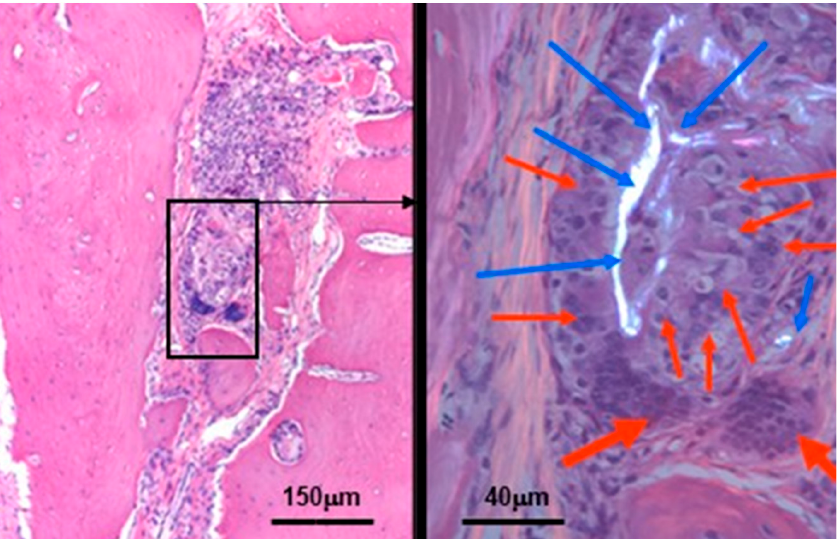
Figure 14. Residual silica compounds following mesoporous BTCP-AE insertion into the calvaria bone defect 6 months after treatment. The hematoxylin-eosin (HE) stained image ( left ) shows sub-total re-ossification of the defect at this time, highlighted by the solid hypocellular pink tissue. However, the center of the picture still mainly exhibits an inflammatory fibrous non-ossified region with the presence of a foreign body giant cell granulomatous reaction in association with the presence of non-metabolized silica crystal particle remnants (within the black frame). This region is magnified (630 × ) in the right-hand side image, which was photographed in a polarizing microscope to confirm the presence of crystalloid foreign particles (the birefringent bright white materials, indicated by the blue arrows) surrounded by the epithelioid-activated macrophages (thin red arrows) and the multinuclear (foreign body) giant cells (thick red arrows) [32].